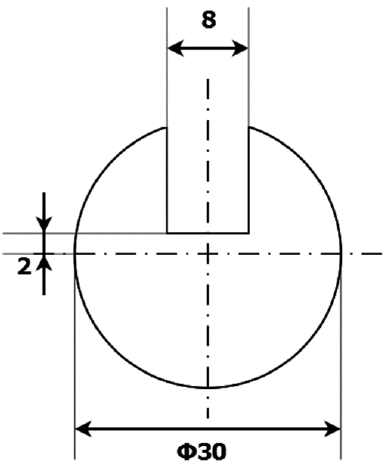
Figure 1. Cross-section of the sample showing a reference defect with a width of 8